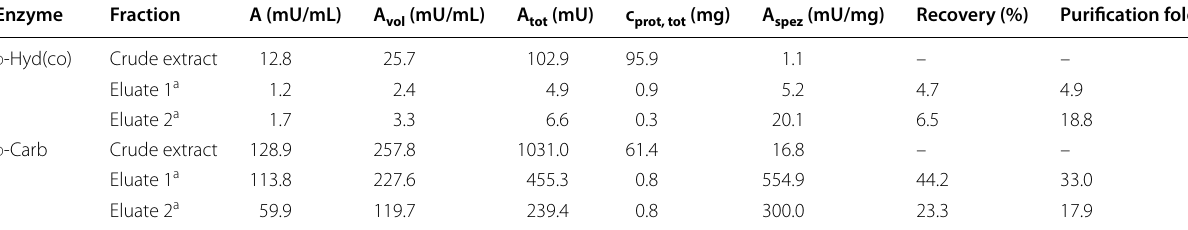
Table 1 Purification of the d -Hyd(co) and d -Carb via Ni Sepharose beads